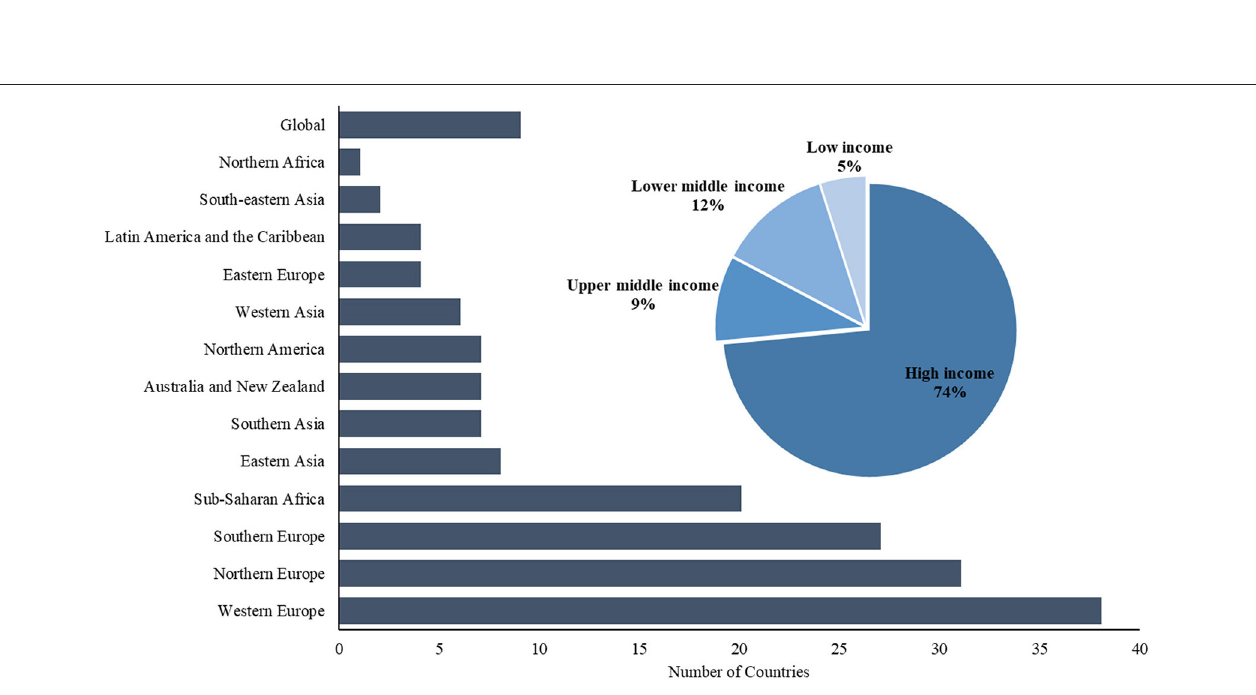
Frontiers in Sustainable Food Systems |